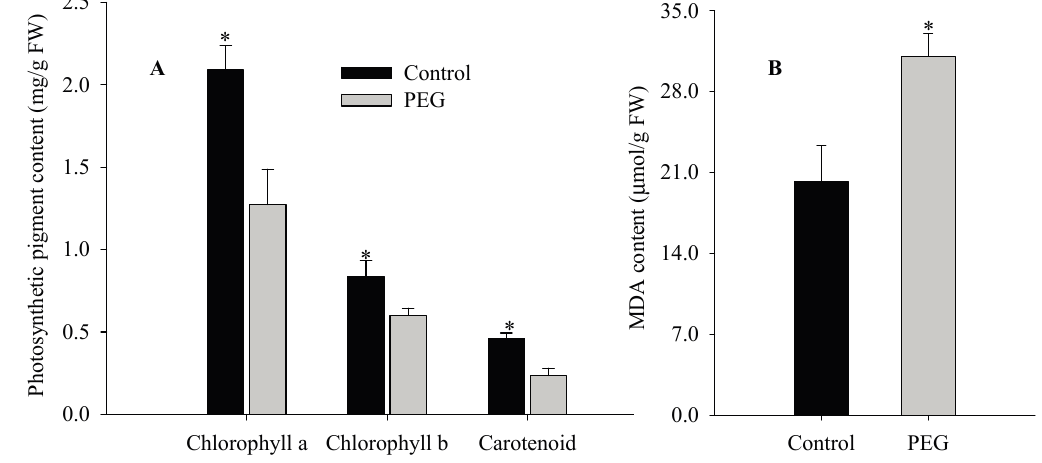
Figure 1. Phenotypes ( A ), plant height ( B ), relative water content of leaf ( C ), shoot fresh weights ( D ) and dry weights ( E ) of maize seedlings exposed to 20% PEG-stimulated water deficiency for two days. Arrowheads indicate the wilted leaves. Asterisks indicate significant differences between control and PEG-stressed maize seedlings at p < 0.05. Significant differences are determined by performing a one-way analysis of variance (ANOVA). Bars represent standard errors of triplicate experiments.